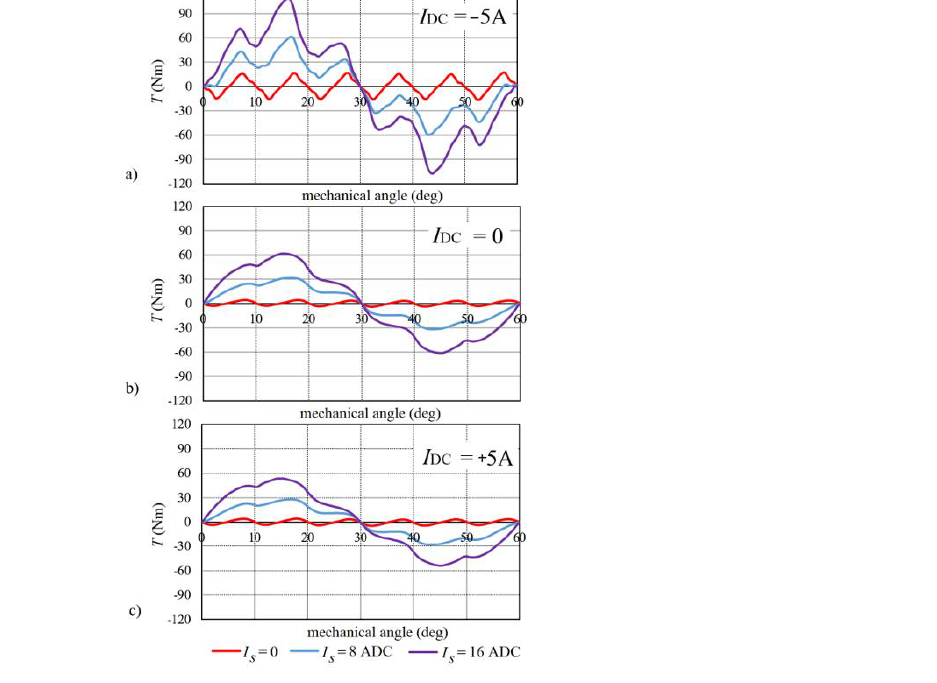
Figure 8. Electromagnetic torque waveforms versus rotor position under different stator currents for three I DC current excitations I DC − 5 A ( a ), I DC = 0 A ( b ) and I DC +5 A ( c ).